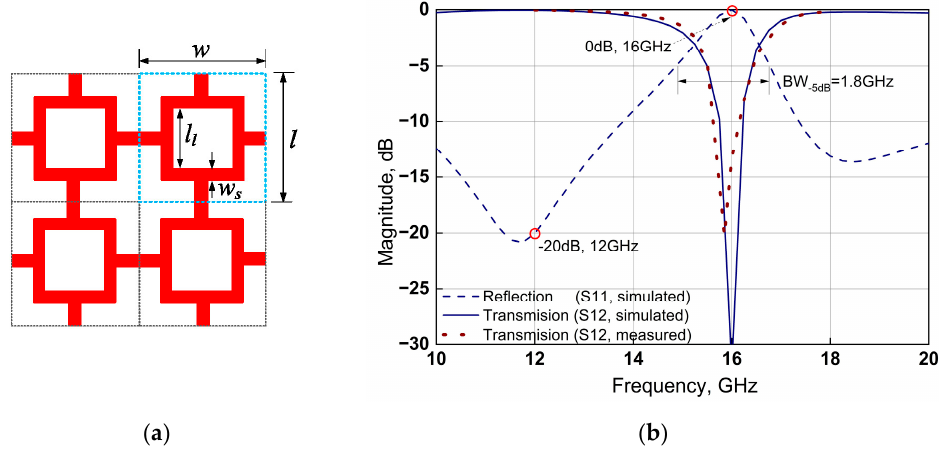
Figure 4. Modified square-loop element FSS ( a ) Geometry: Cell size: l × w = 10 mm × 10 mm, length of loop: l l = 4.25 mm, width of strip line: w s = 0.5 mm. ( b ) S parameters V.S. frequencies for Modified FSS.